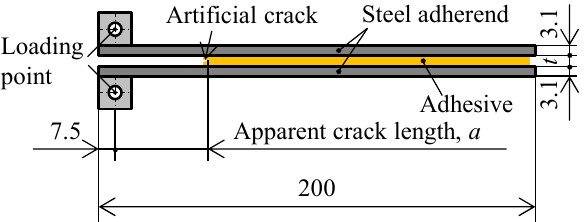
Figure 1. Shape and dimensions of the double cantilever beam (DCB) specimen (unit: mm).